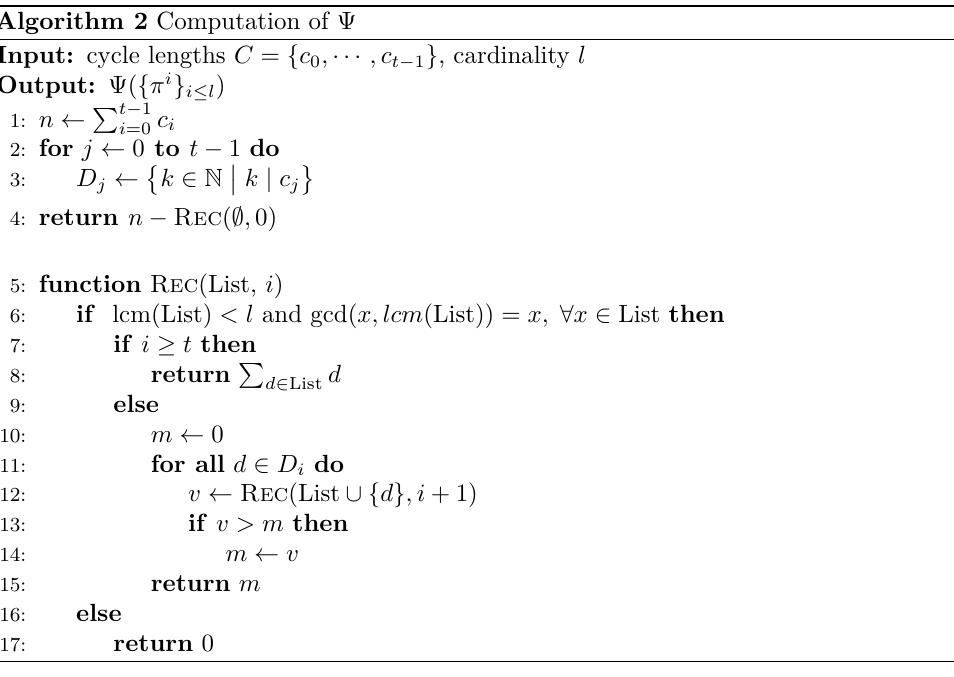
Algorithm 2 Computation of